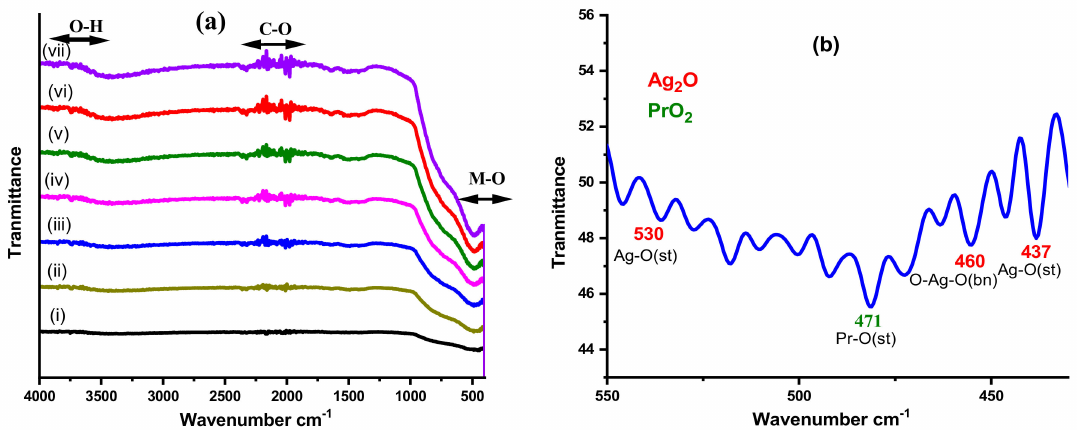
Figure 3. ( a ) FTIR spectra of γ -Al 2 O 3 and Ag 2 O ( X ) –PrO 2( Y ) / γ -Al 2 O 3 nanomaterials. ( b ) FTIR spectrum representing vibration modes of Ag-O and Pr-O